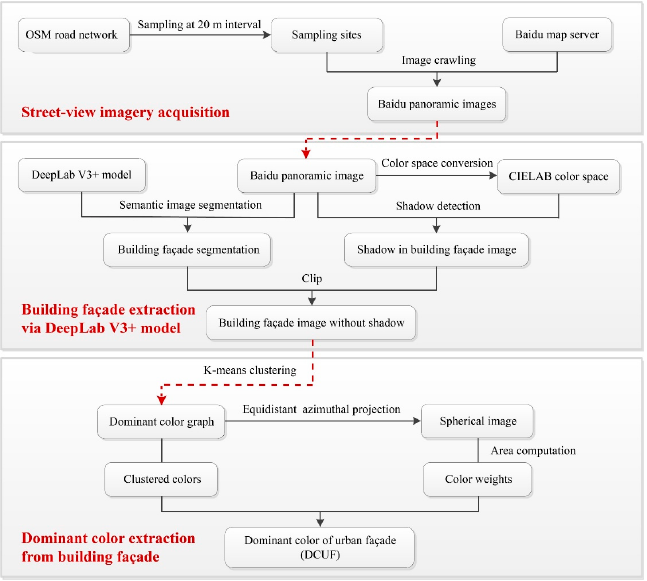
Figure 2. Flowchart of determining the DCUF from the street view image at a location.